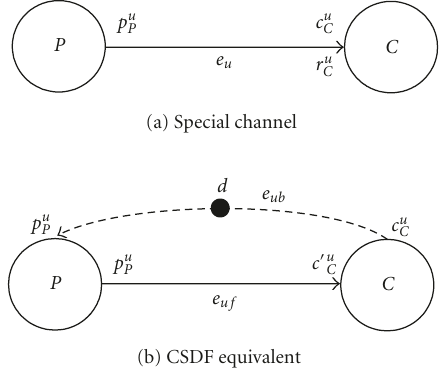
Figure 3: Nondestructive reads between a producer P with period L P and production sequence sumer C with period L C and sequences r = { r u C (0), ... , r u C ( L C − 1) } and c = { c u C (0), ... , c u C ( L C − 1) } for which c u C ( j ) ≤ r u C ( j